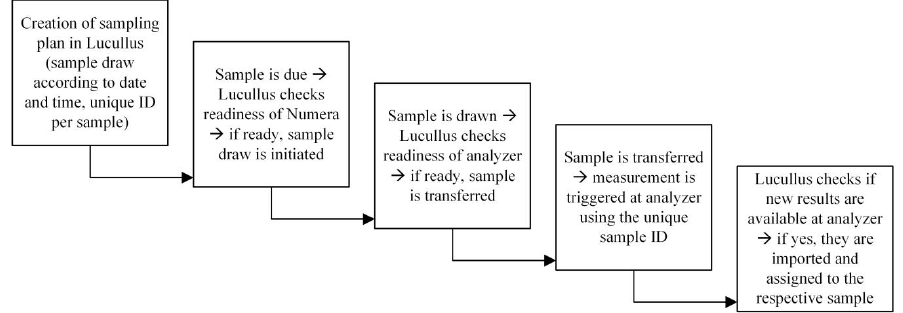
Figure 3. Coordination of the sampling procedure performed by the software Lucullus PIMS.